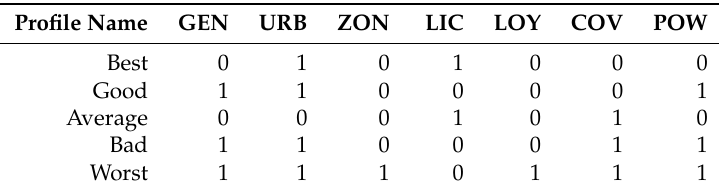
Table 4. The 5 profiles used for the comparisons.